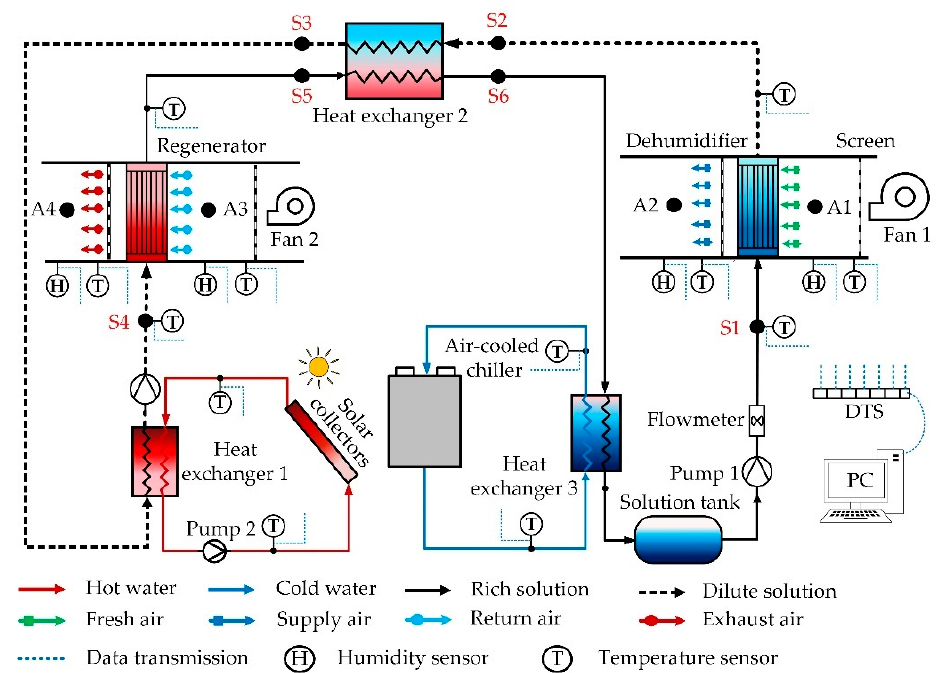
Figure 4. Schematic diagram of the hollow membrane liquid dehumidifier system.